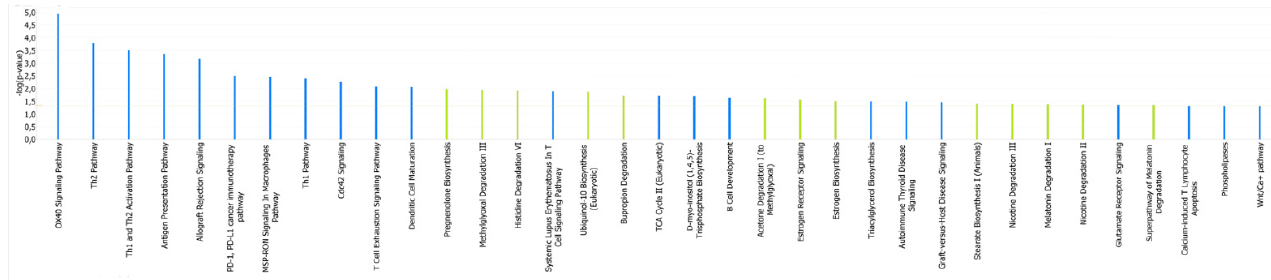
Figure 3. Main pathways related to the significantly differentially methylated CpG sites. Blue bars: biochemical pathways with CpGs sites hypermethylated in stable MHO. Green bars: biochemical pathways with CpGs sites hypermethylated in unstable MHO.A network analysis was performed to examine the inter-relationships between these genes. Almost half of them were linked in a unique network with transcription factors and transcription regulators (AHR, SIP1 or HNF4A) as the main nodes (Figure 4).